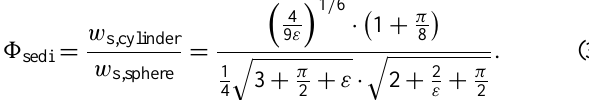
tion depends on the particles’ orientation, random orienta- tion can be assumed for mesospheric ice: by way of their small size, rotational Brownian motion contributes a signifi- cant part of their thermal energy, equally distributed over all axes. Gadsden (1983) estimated this rotation at ≈ 10 6 Hz, so the randomization process is orders of magnitude faster than the MIMAS resolution of 90 s. The random particle orienta- tion allows calculating an average vertical cross section for collisions with air molecules, which determines the sedimen- tation rate w s . As this cross section increases for elongated and flattened particles for a given volume, needle- and disc- shaped particles fall more slowly than spheres: